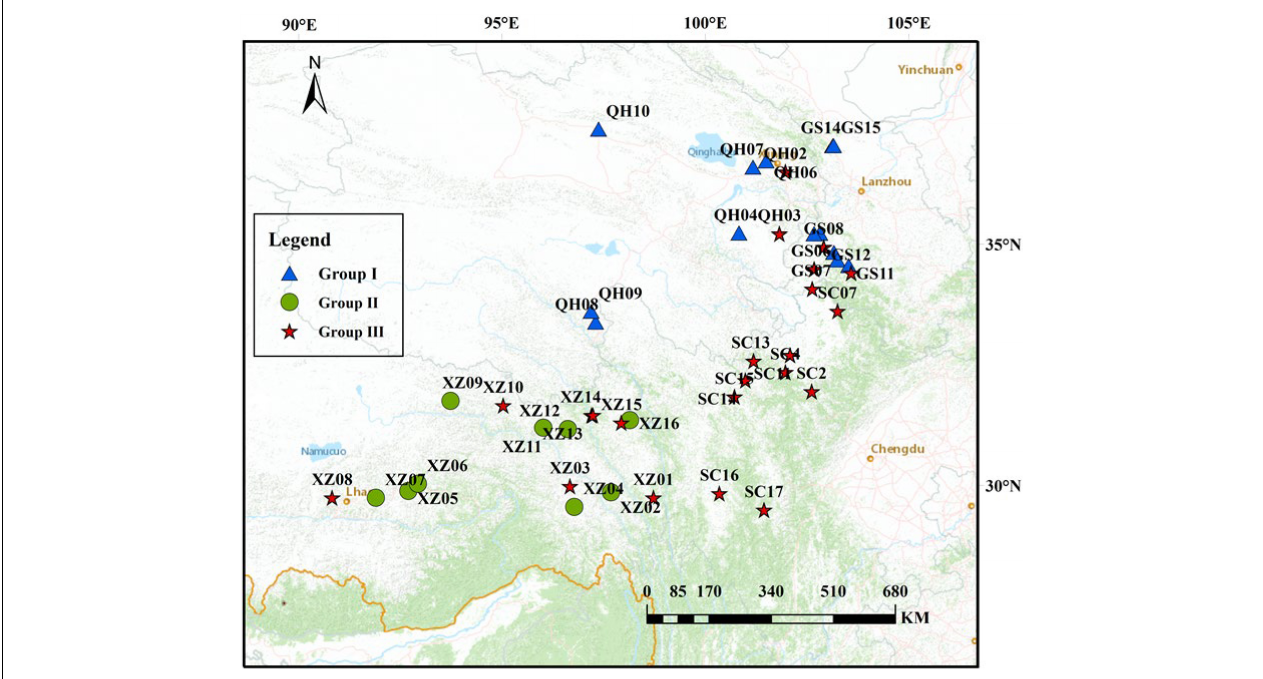
FIGURE 1 | Geographic location of E. sibiricus populations in this study (the population geographic distribution of best results in clusters by Admixture).